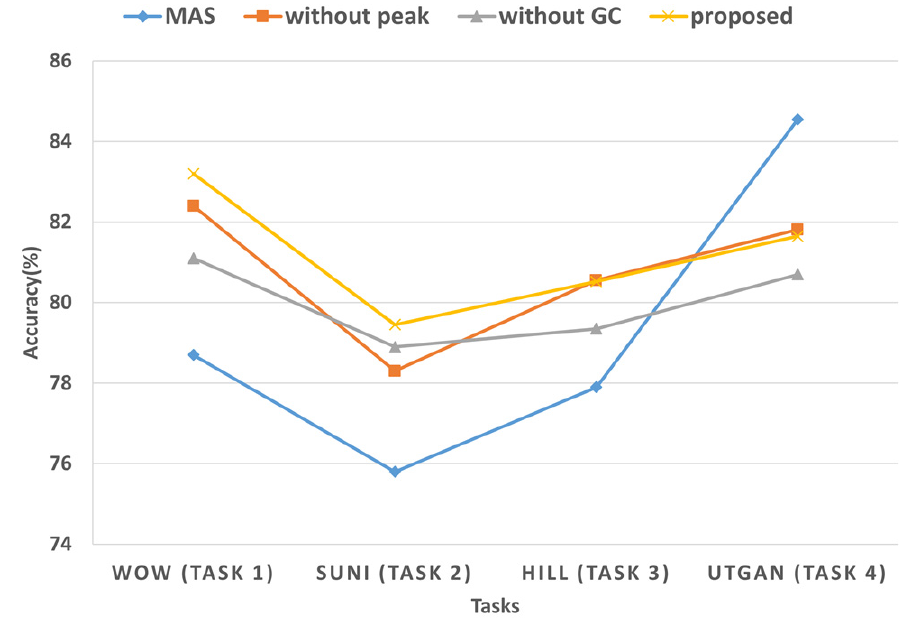
Figure 4. Ablation analysis of the proposed curvature-based weight estimation algorithm, Peak- weight algorithm, and MAS against four steganographic methods in terms of detection accuracy.